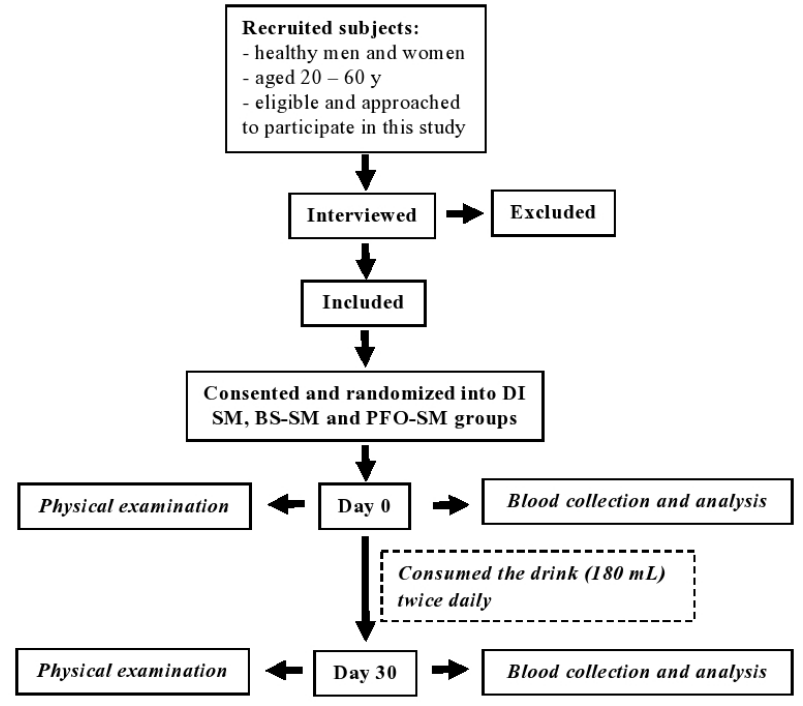
Figure 1. Overview of recruitment, randomization, and intervention protocols in the study.